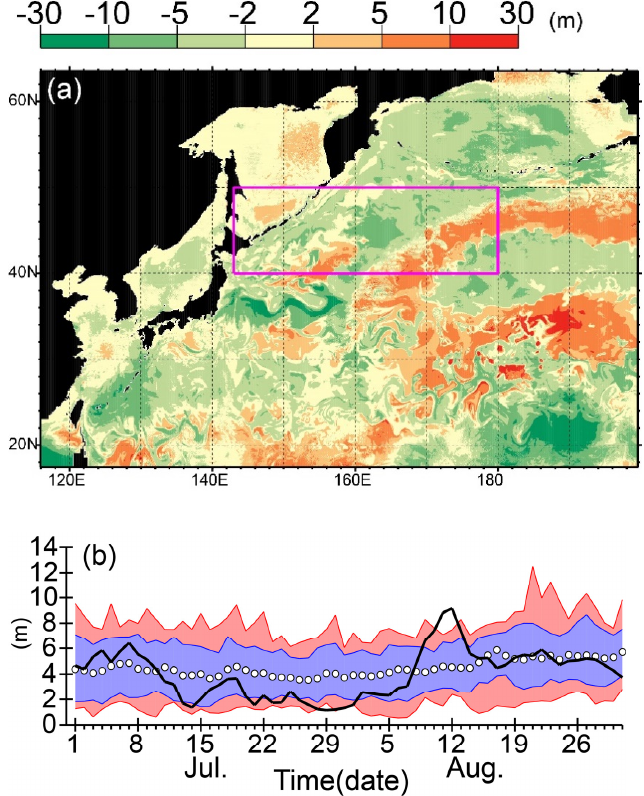
Figure 6. ( a ) Thickness anomalies of the oceanic surface boundary layer during 10–30 July 2021, estimated by a mixed layer model based on K-profile parameterization in the 1/10° ocean circulation model. Climatological means were estimated by averaging the thickness over 30 sensitivity simulations based on external forcings in 1990–2019. ( b ) Time series of oceanic surface boundary layer thickness spatially averaged over the focal area (143°E–180° and 40°–50°N; the purple rectangle in a ). The bold black line shows the daily time series in 2021. Open circles denote daily means of the 30 simulations. Blue shading shows the 10th to 90th percentile range. Red shading shows the range, beyond these percentiles, between the minimum and maximum.